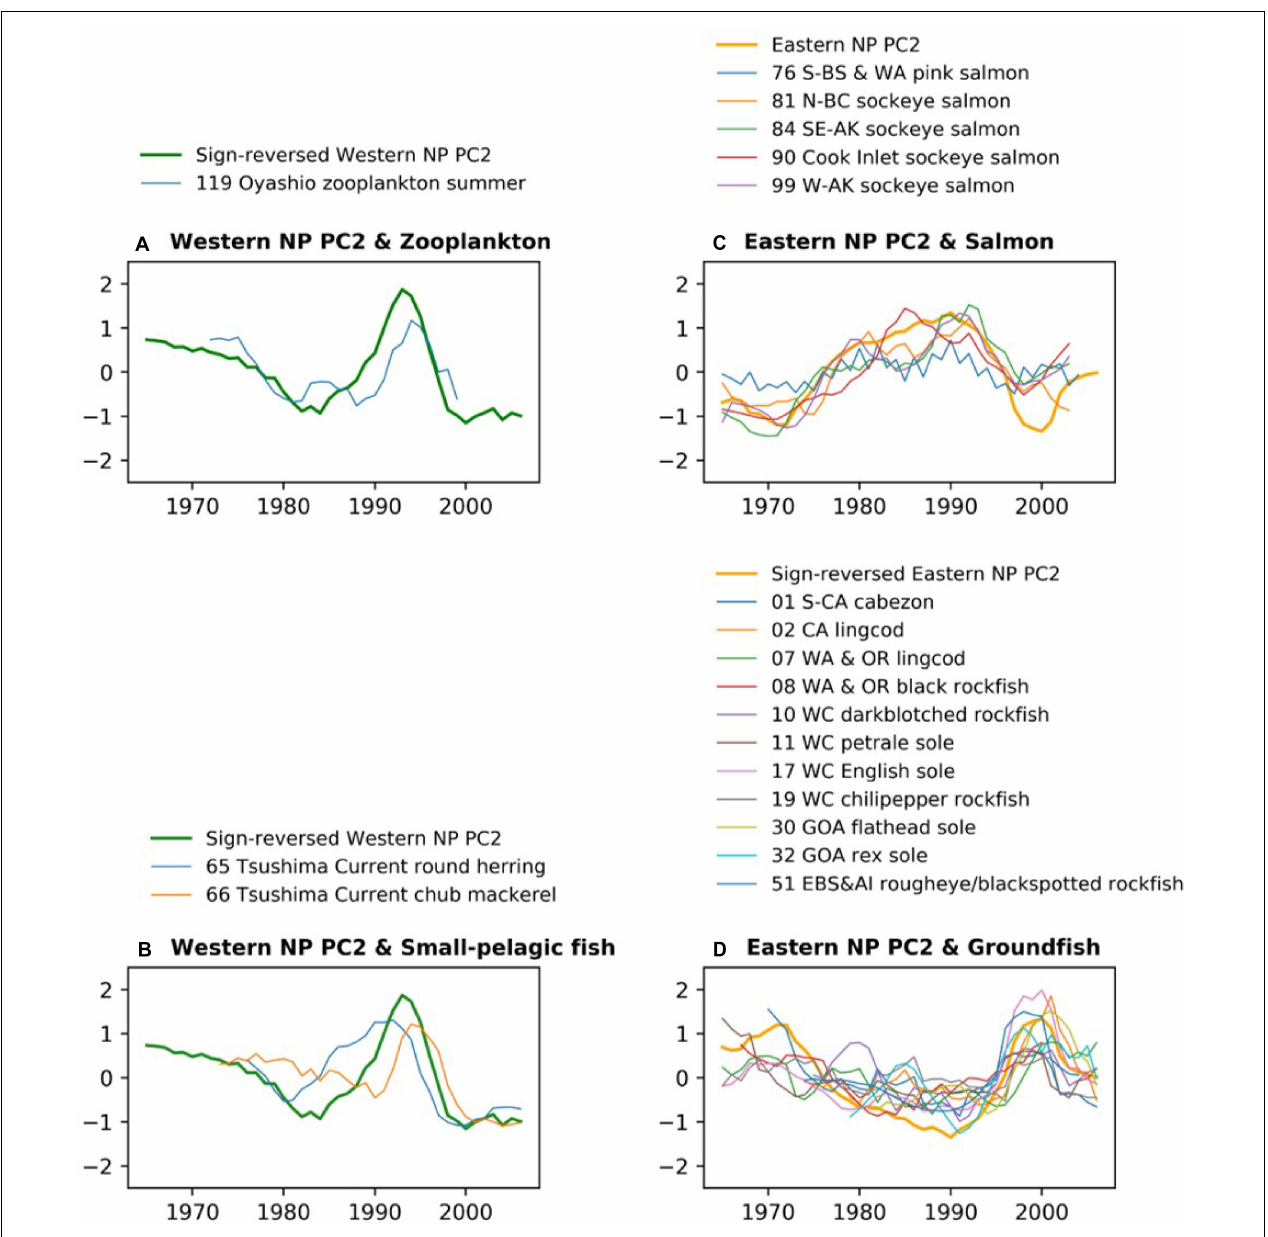
FIGURE 5 | As in Figure 3 , but for western NP (A) zooplankton and (B) small pelagic fish along with western NP PC2, and eastern NP (C) salmon and (D) groundfish along with eastern NP PC2. All time series are smoothed by 5-year running mean. For an easier comparison, the PC2 time series are sign-reversed (multiplied by –1) for (A,B,D)